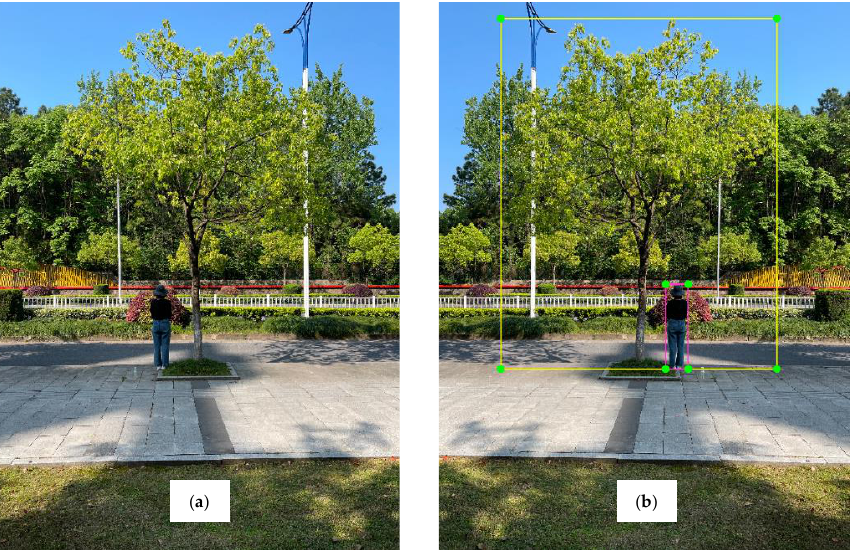
Figure 3. ( a ) Image of a person and tree before labeling. ( b ) Image of a person and tree after labeling.